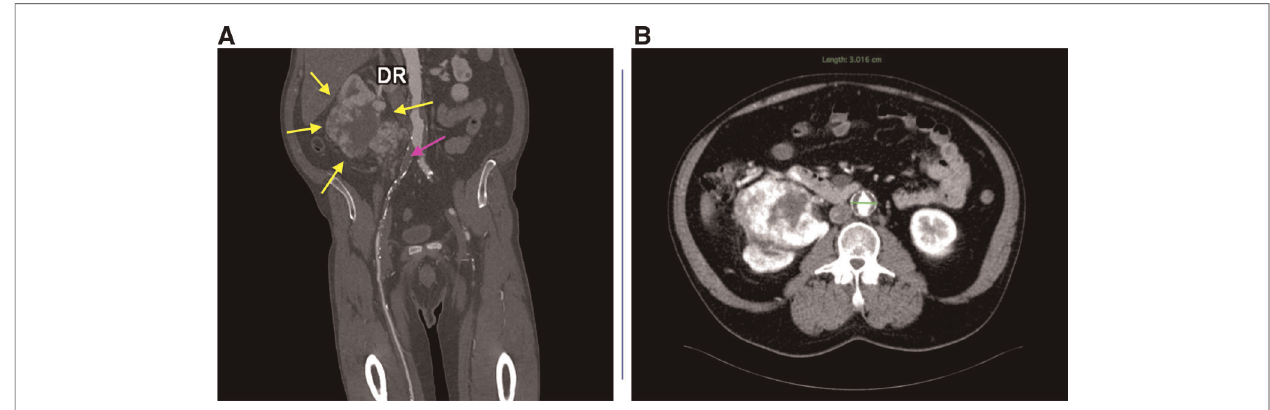
FIGURE 1 | Computed tomography angiography before surgery: coronal section, yellow arrows: kidney tumor; purple arrow: occlusion of the right common and external iliac arteries ( A ) and axial section, AAA with intraluminal thrombus; renal tumoral mass with central necrosis ( B